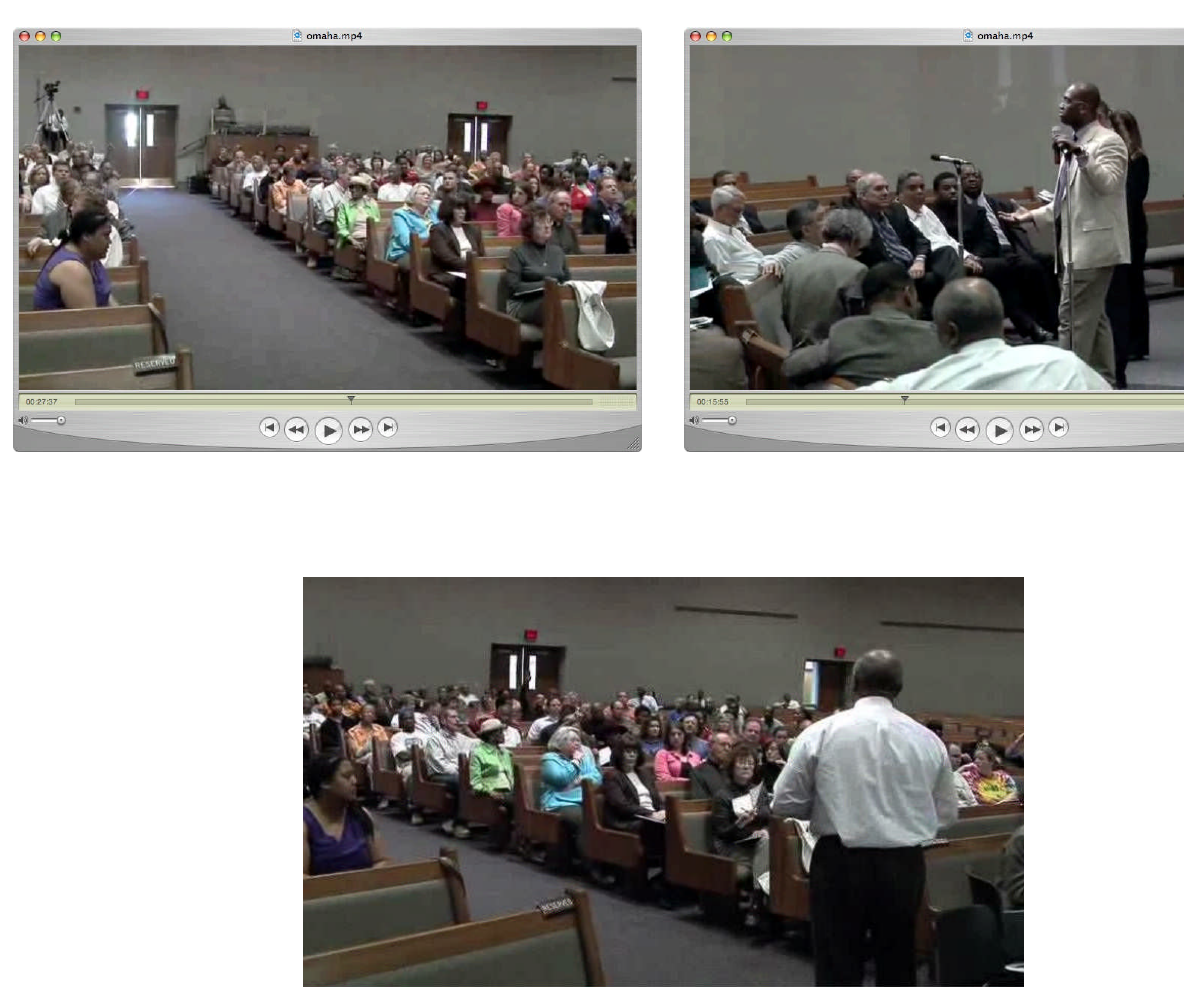
Figure 1: Two main groups formed through their physical and spatial behaviors, and two Reserved